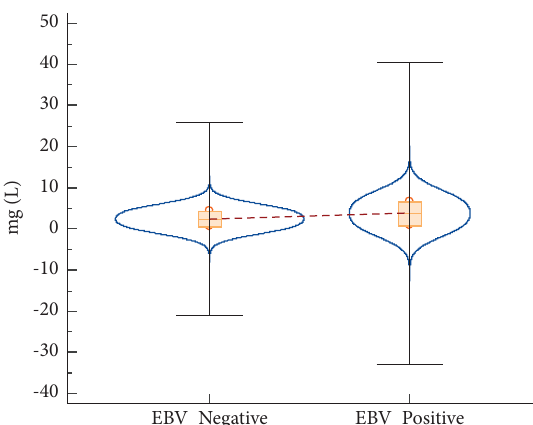
Figure 3: Te violin plot of level of D-dimer in EBV( − )/SARS- CoV-2(+) and EBV(+)/SARS-CoV-2(+) group, respectively. Te data were extracted from Xie et al. [1] and Meng et al. [12]. Te D- dimer was not statistically signifcantly diferent between these 2 groups ( p > 0 .